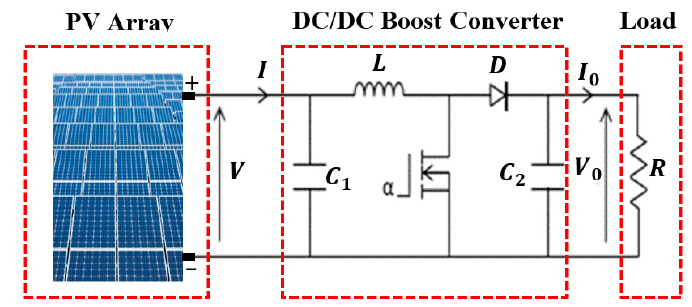
Figure 5. Boost converter circuit schematic.